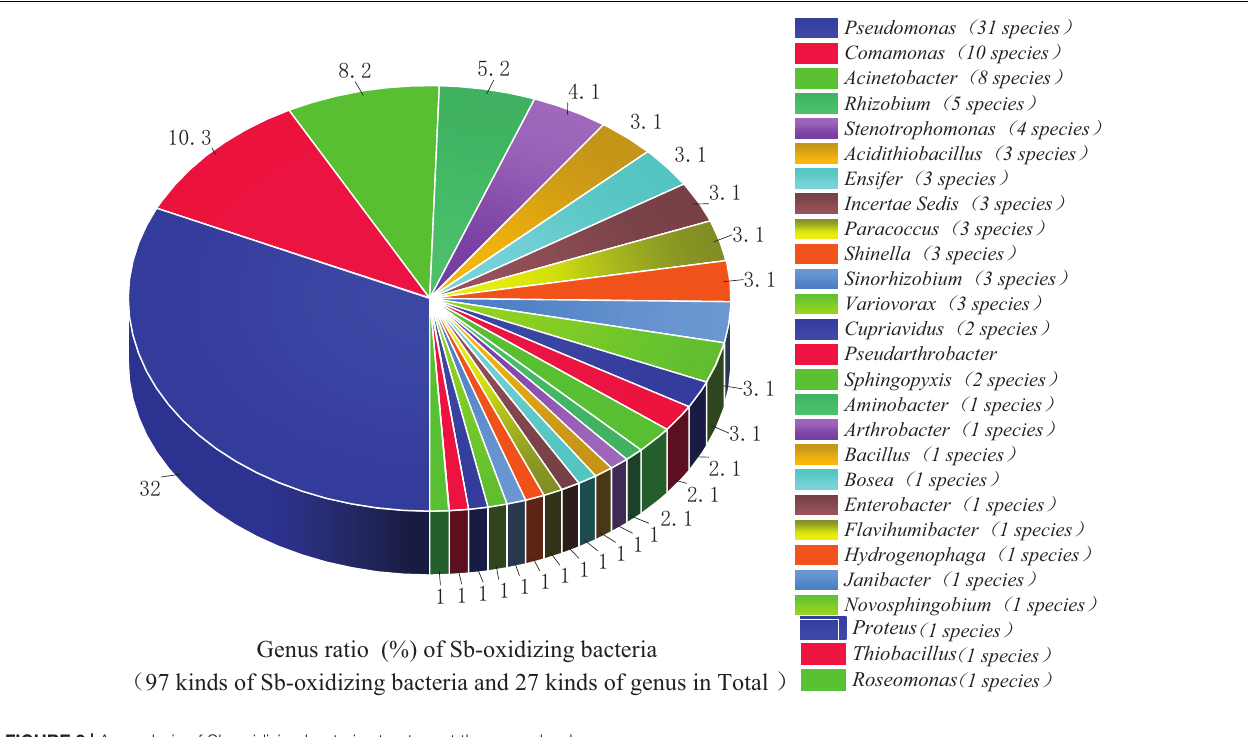
FIGURE 3 | An analysis of Sb-oxidizing bacteria structure at the genus